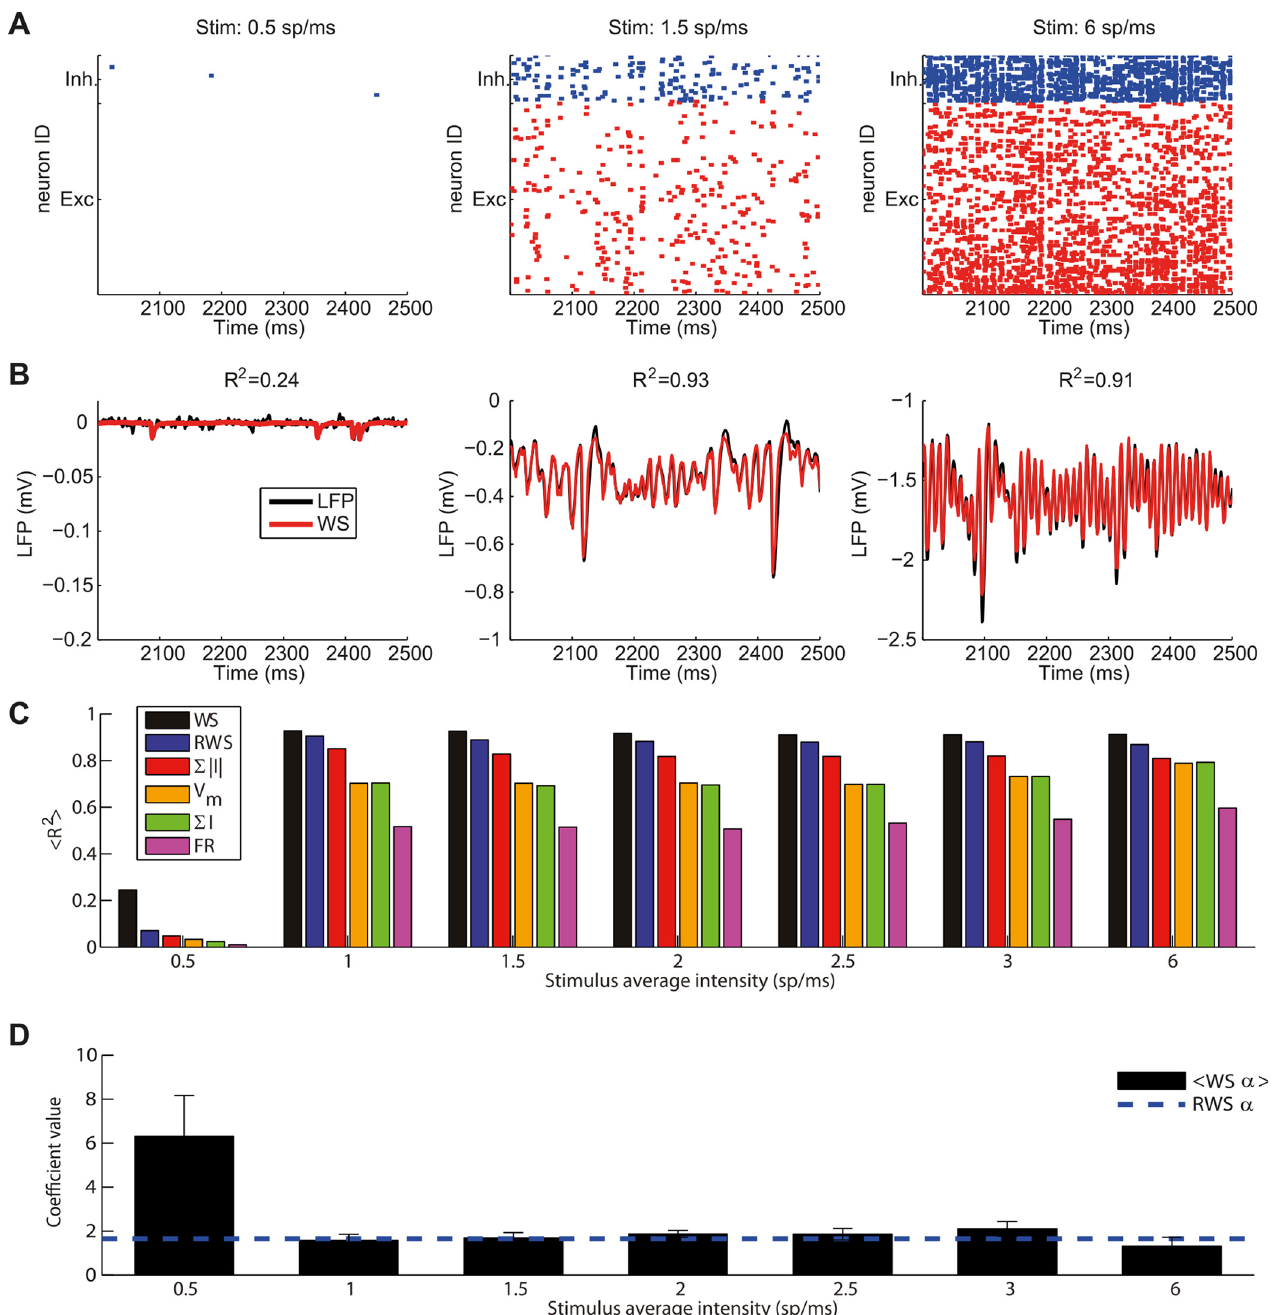
Fig 6. Effects of dynamic network states of the LIF model on the simulated LFP signal. (A) Raster plots of 50 interneurons (blue, top) and 200 pyramidal neurons (red, bottom). Neurons displayed are those with the highest number of spikes fired in the considered interval. Each panel corresponds to a different stimulation frequency: from left to right: 0.5 spikes/ms, 1.5 spikes/ms (the stimulation used in Figs 1 – 4), 6 spikes/ms. Note that in the selected interval all pyramidal neurons and most interneurons were silent for 0.5 spikes/ms stimulation. (B) LFP signal (black line) for 100 μ m depth and corresponding best fit with the WS proxy (red) for these three stimulation frequencies. The titles show the fraction of variance explained over the whole 10 second simulation period. Note the different vertical scales. (C) Average fraction of LFP variance explained over all depths by different proxies for different thalamic input frequencies. Error bars are not displayed since they would not be visible in the figure. Same proxy arrangement as Fig 5C. (D) Mean and standard deviation across depths of optimal coefficients of α in the WS proxy as a function of thalamic input. Dashed line indicates the fixed coefficient of the RWS